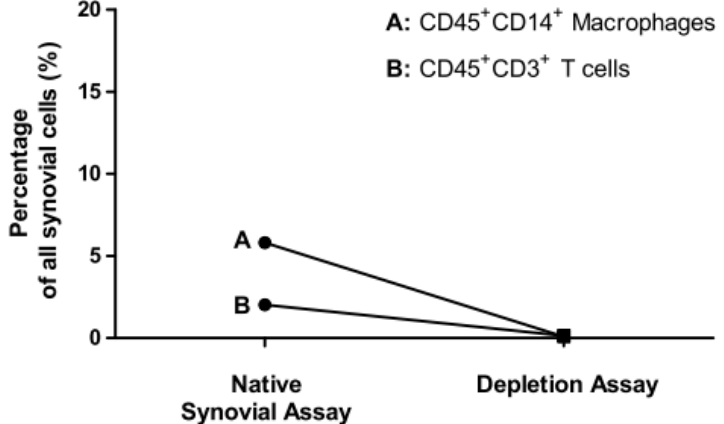
Figure 4. Depletion of synovial macrophages and T cells shown by flow cytometry analyses. Display of the mean values of: Percentage of CD45 + CD14 + macrophages ( A ) and CD45 + CD3 + T cells ( B ) on all living synovial cells in the samples of the native synovial assays and macrophages ( n = 10) and T cell depletion assays ( n = 12).